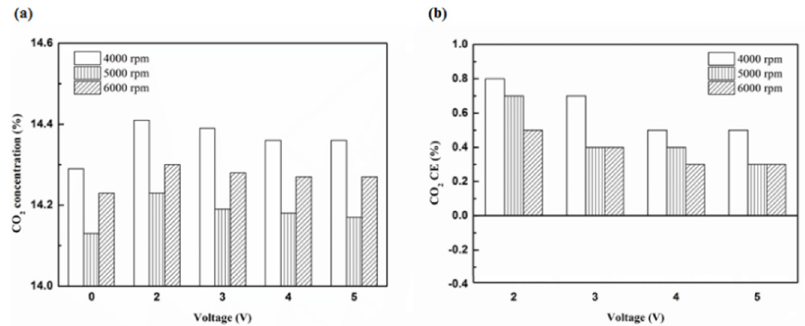
Figure 21. The CO 2 ( a ) emission values and ( b ) CE using iridium alloy in the front of the exhaust pipe.